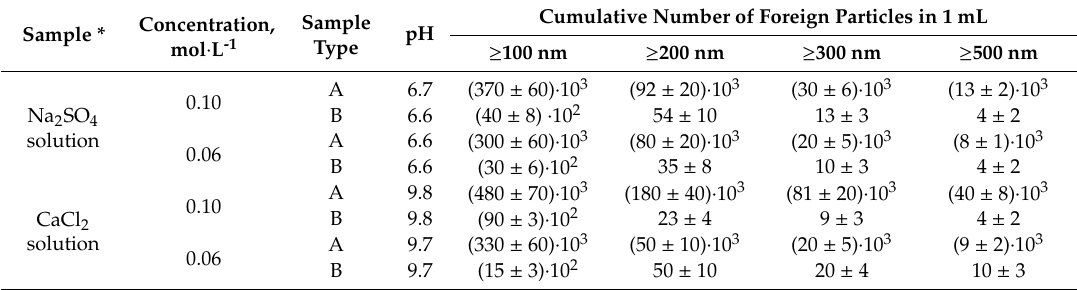
Table 3. The stock solutions characterization by a particle